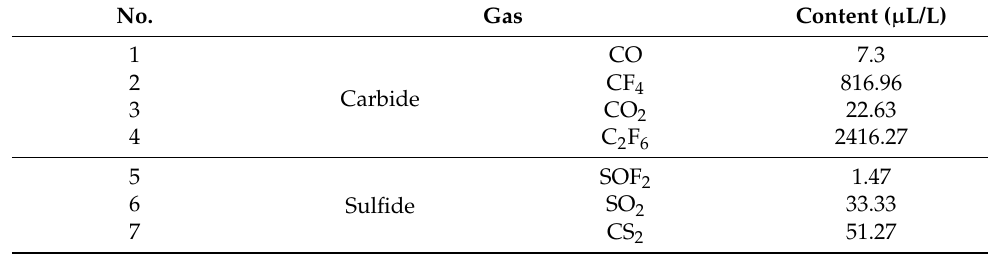
Table 2. Gas composition of test circuit breaker samples.